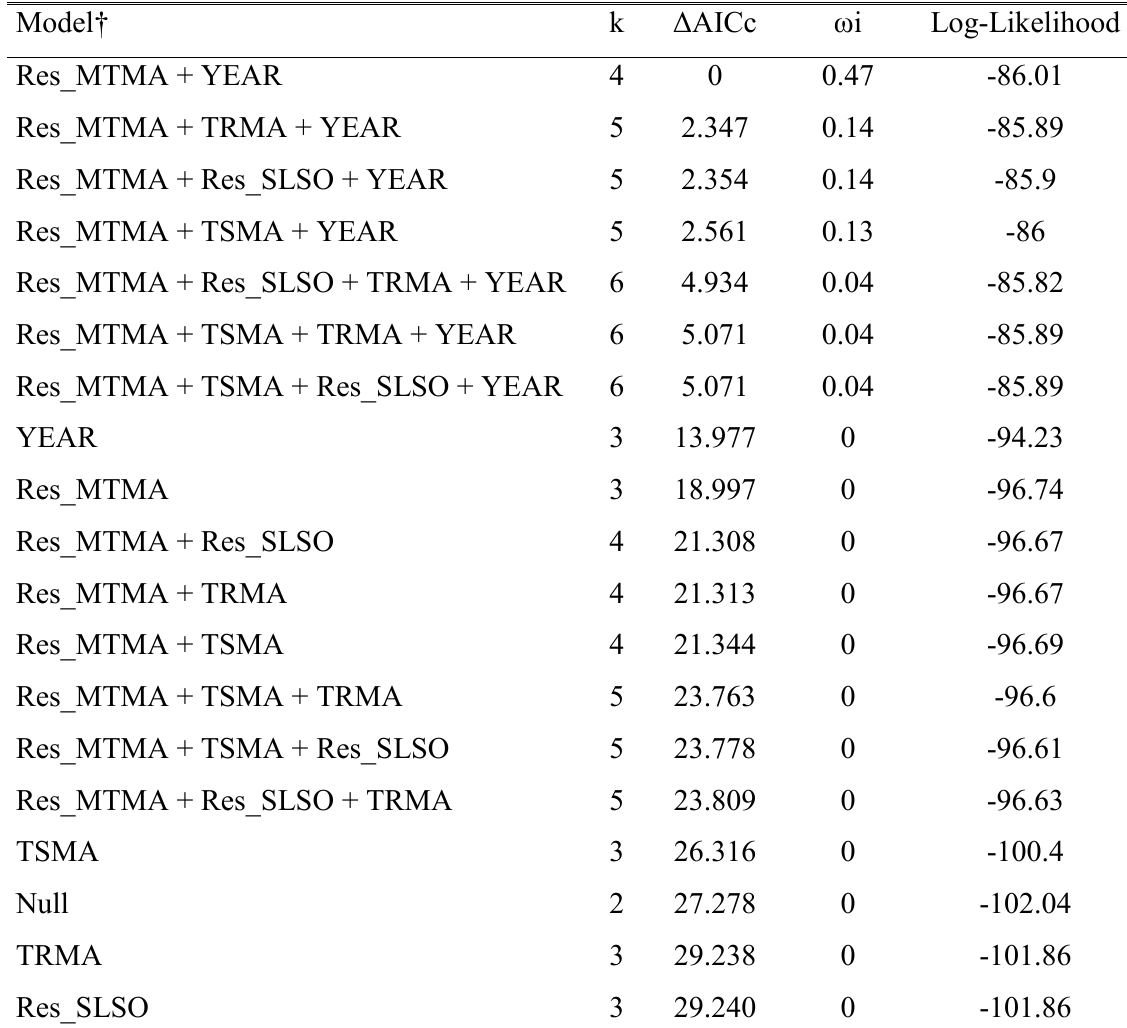
Table A1.1. Ranking of models explaining variation in median spring arrival date of Ring-billed Gulls in southern Quebec determined from Étude des Populations d’Oiseaux du Québec (EPOQ),